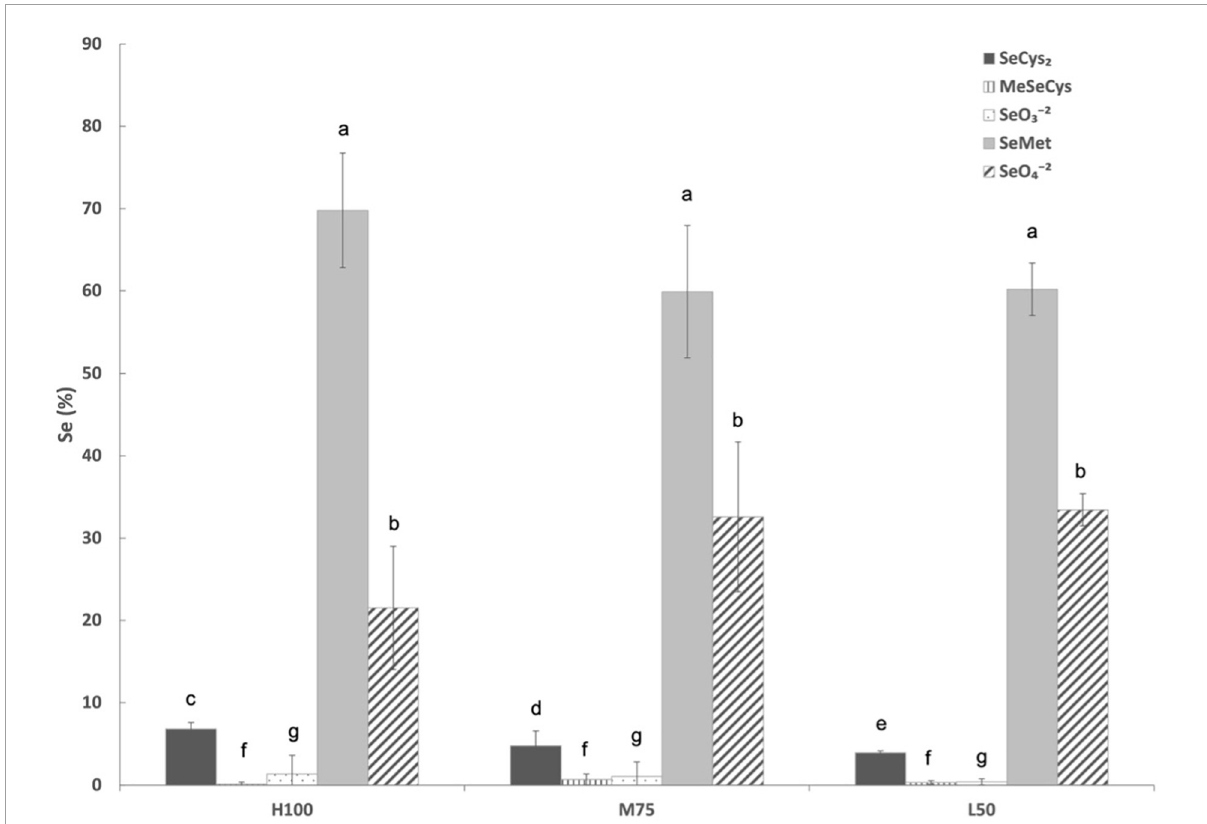
FIGURE6 Selenium speciation in direct seeded agretti grown in 2021 and irrigated with saline waters at different rates. Statistical difference was performed to analyze the effect of irrigation levels within each planting year (H100 = high 100% Et o , M75 = medium 75% Et o , and L50 = low 50% Et o ) as described in Table 3 . Values represent the mean ( n = 3) and error bars represent standard deviation. Different letters indicate that values differed significantly ( P ≤ 0.05), ns = not significant. SeCys 2 : Selenocysteine; MeSeCys: Methylselenocysteine; SeO 3 - 2 : Selenite; SeMet: Selenomethionine; SeO 4 - 2 :